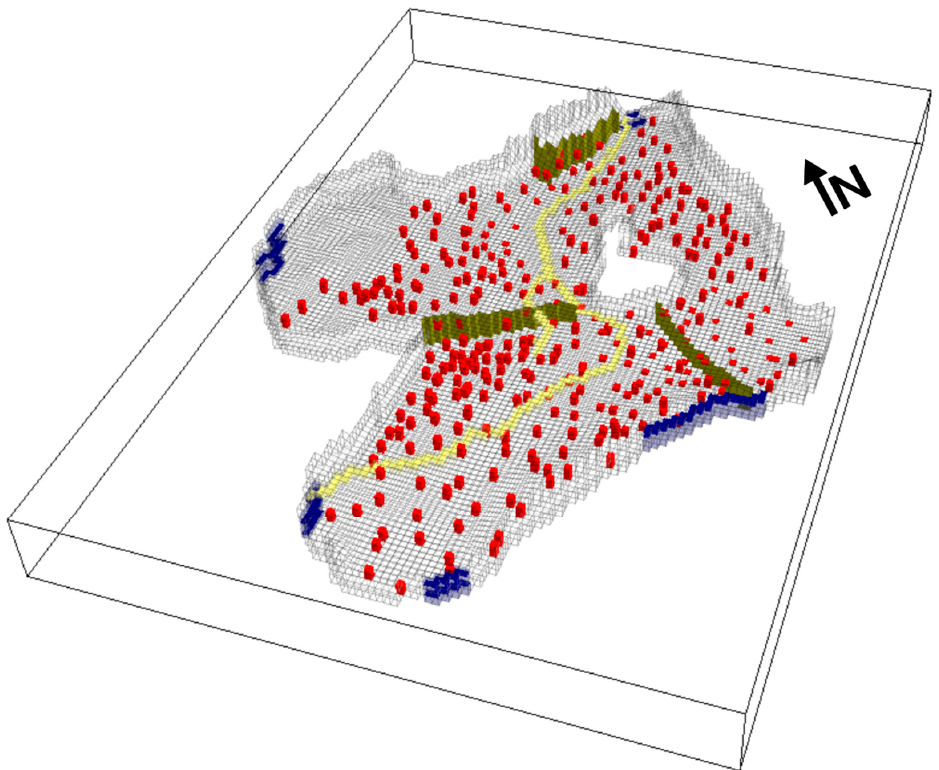
Figure 8. 3D discretization and boundary conditions of the Mio-Plio-Quaternary aquifer system: drain cells representing the Wadis (yellow), pumping wells (red), General Head Boundary representing the inflow and outflow from the basin (blue), and HFB representing the major faults (olive green). Vertical exaggeration is 1:20.